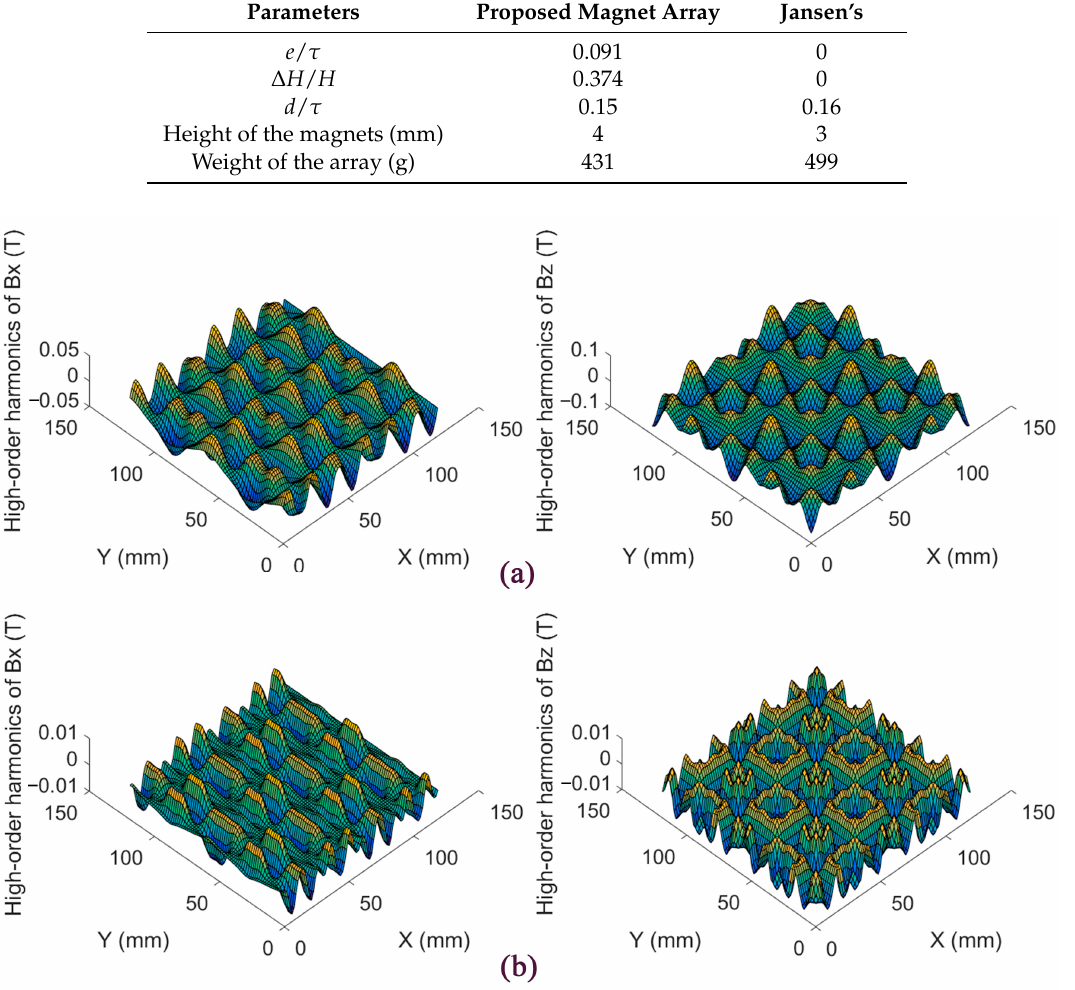
Figure 5. The high-order harmonics in the m x - and m z -directions. ( a ) Jansen’s design; ( b ) This proposed design.